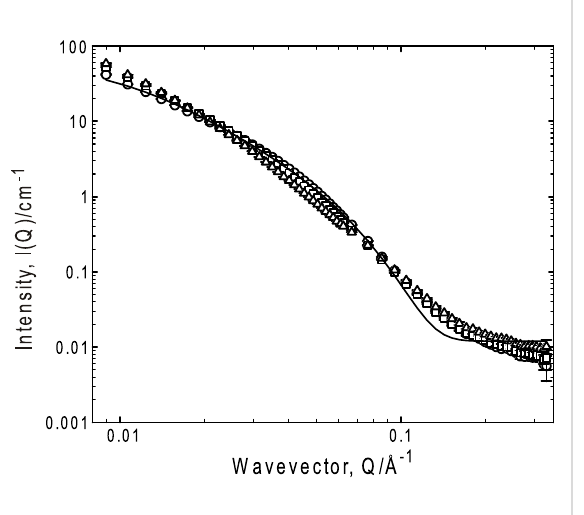
Figure 4: SANS from a series of homologous gelators, G 5 (circles), G 6 (squares) and G 8 (triangles) in d- toluene, all at 50 mg ml − 1 and 25 °C. Selected fits to the Kholodenko–Dirac worm model are superimposed on the data.